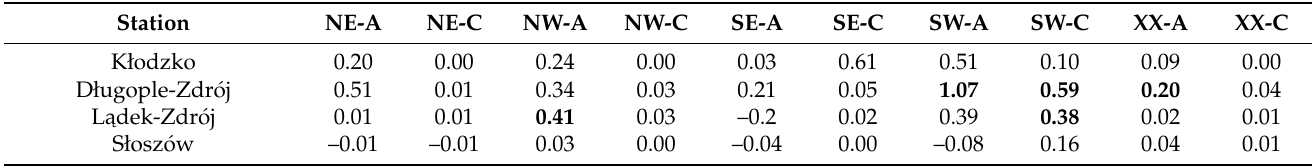
Table 9. Changes (days per decade) in the number of days with UTCI > 32 ◦ C under particular types of circulation in the summer seasons of 1971–2010 in Kłodzko Land (statistically significant trends marked in bold). Station NE-A